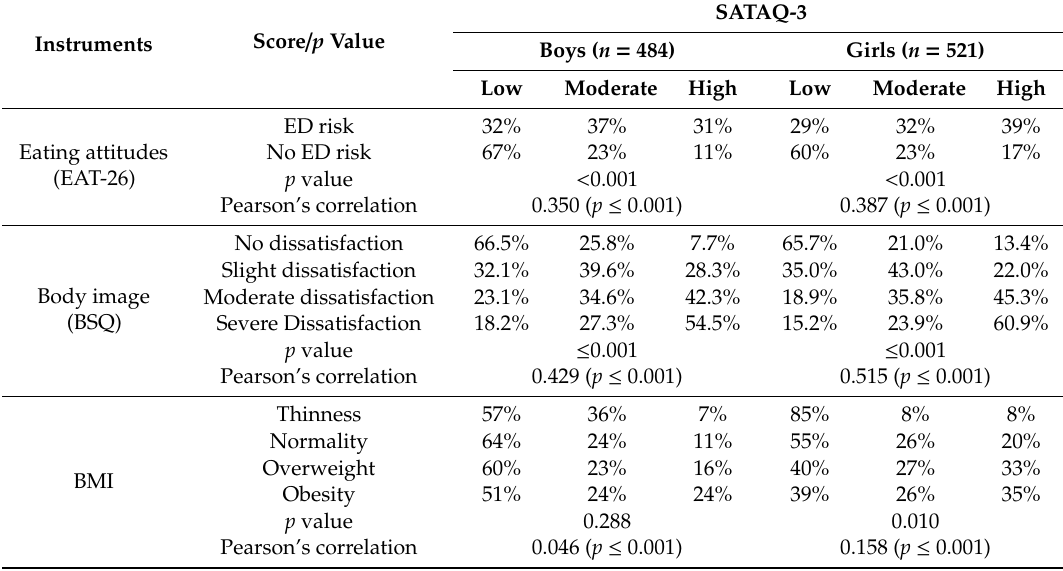
Table 3. Classification of adolescents by EAT-26, body shape questionnaire (BSQ), and BMI and relation with